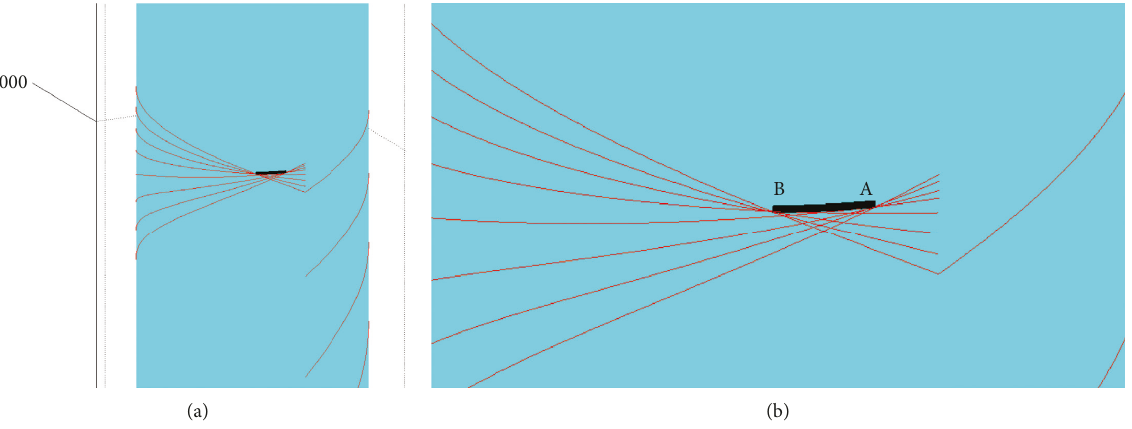
Figure 26: Single-defect segment imaging: (a) partial display and (b) detail display.